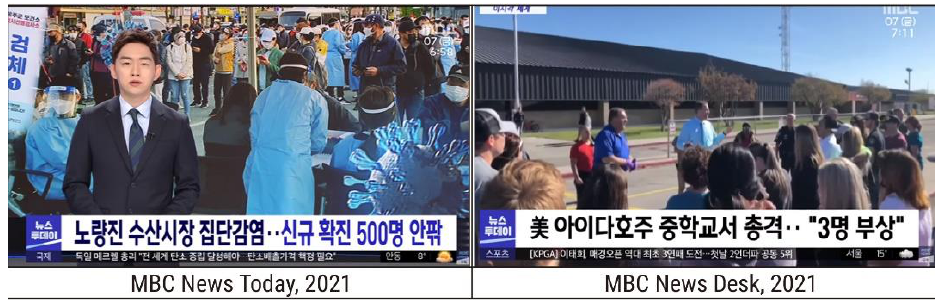
Figure 3. Example of news type broadcasts. Translation of subtitles – Left: “Group infection at Noryangjin Fish Market… Around 500 new confirmed cases” . Right: “Shooting at a middle school in Idaho… 3 people were injured” .